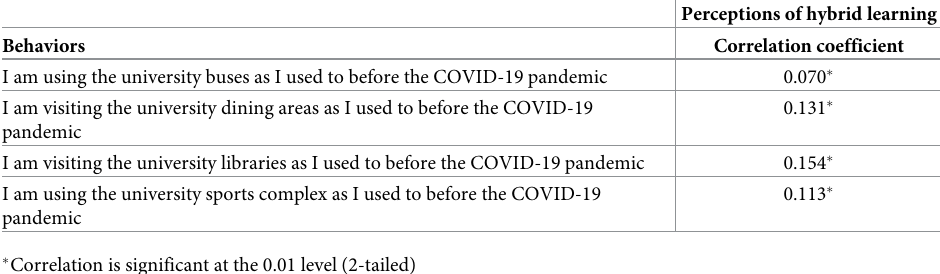
Table 5. Correlation between perceptions and